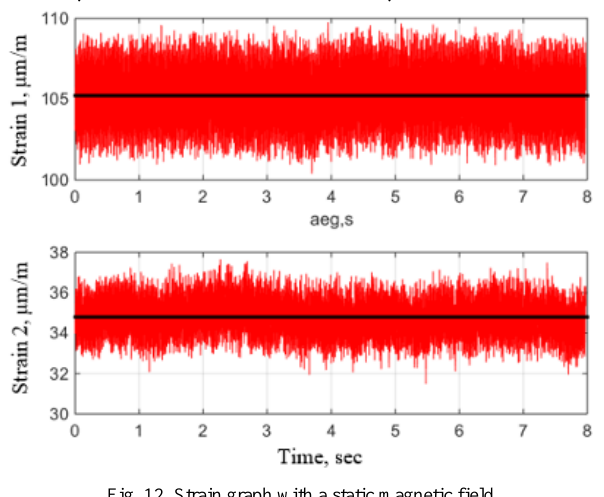
Fig. 12. Strain graph with a static magnetic field.